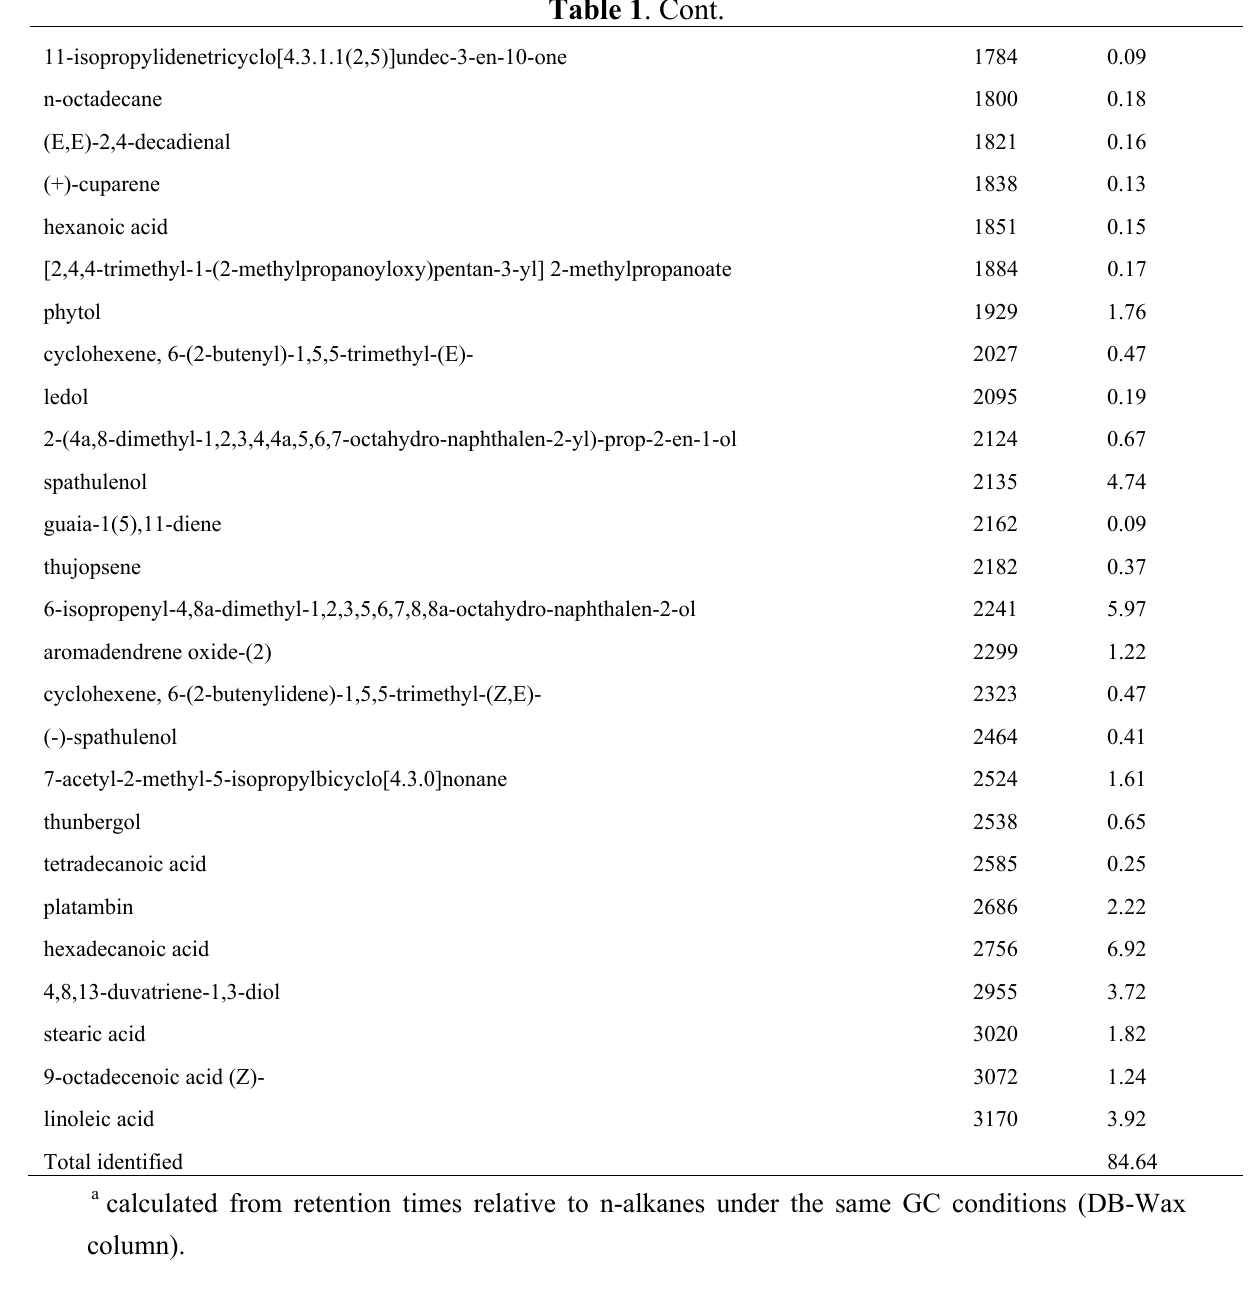
Table 2. A comparative analysis of the composition of Chaetomium fusiforme and the ferment broth PDB without